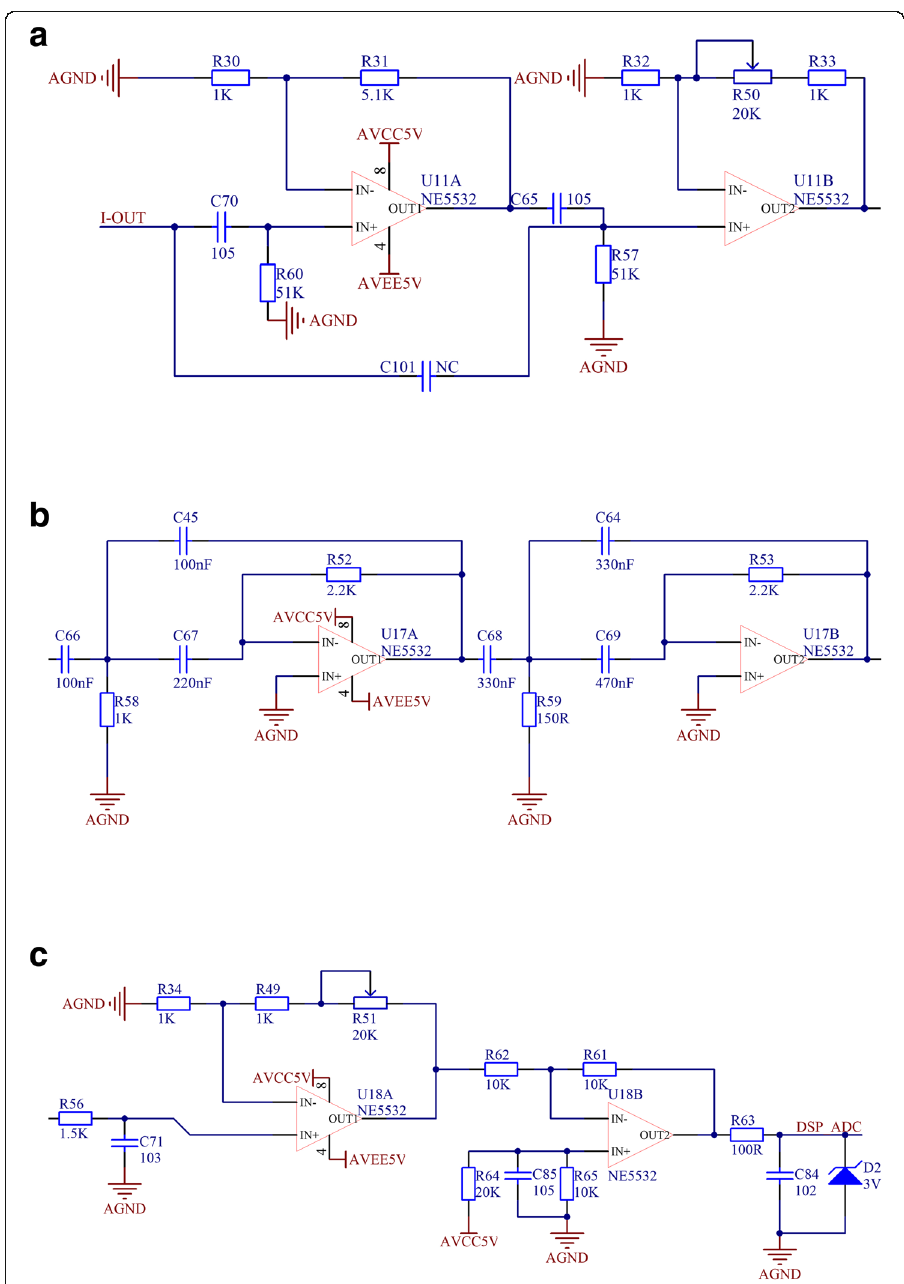
Fig. 4 Analog signal processing circuit. a Two-stage preamplifier. b Active fourth-order high-pass filter. c Single-stage amplifier and booster